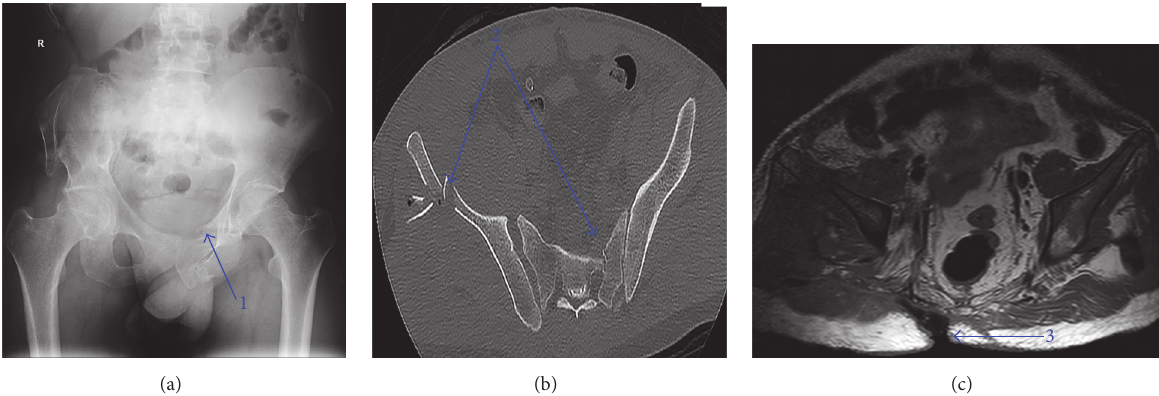
Figure 1: (a) X-ray image of the pelvic fracture four months after trauma (1); (b) Computed Tomography in the fifth day from admission revealing the fracture of the pelvis (2); (c) magnetic resonance imaging 40 days from admission demonstrating the remnant of the perineal wound defect